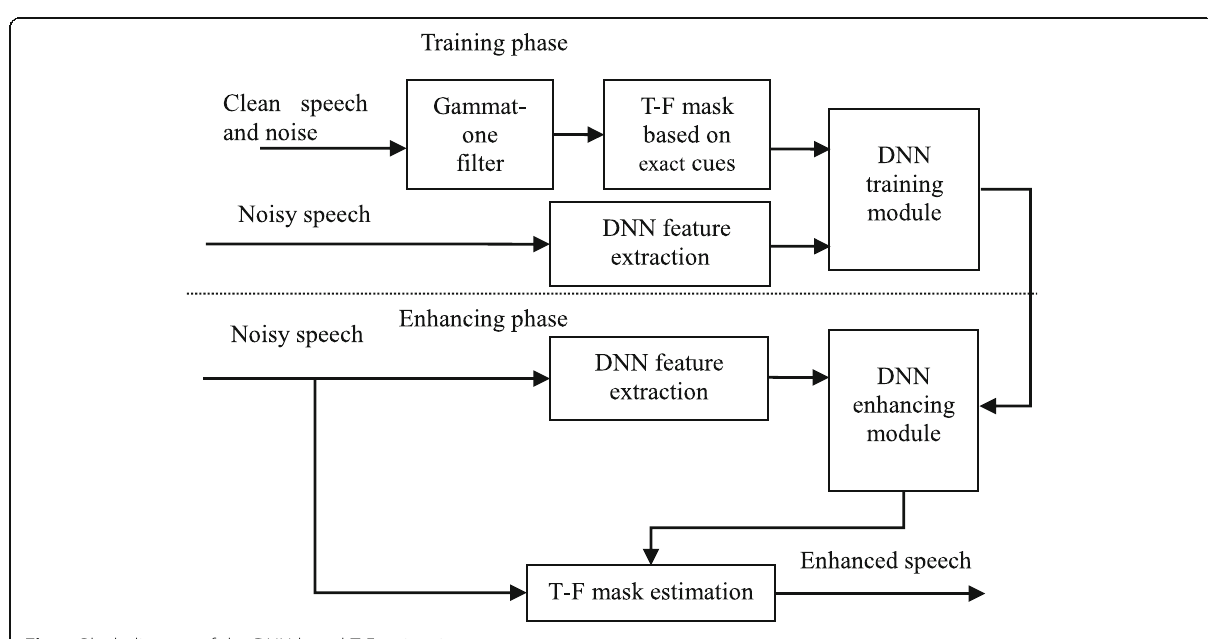
Fig. 5 Block diagram of the DNN-based T-F